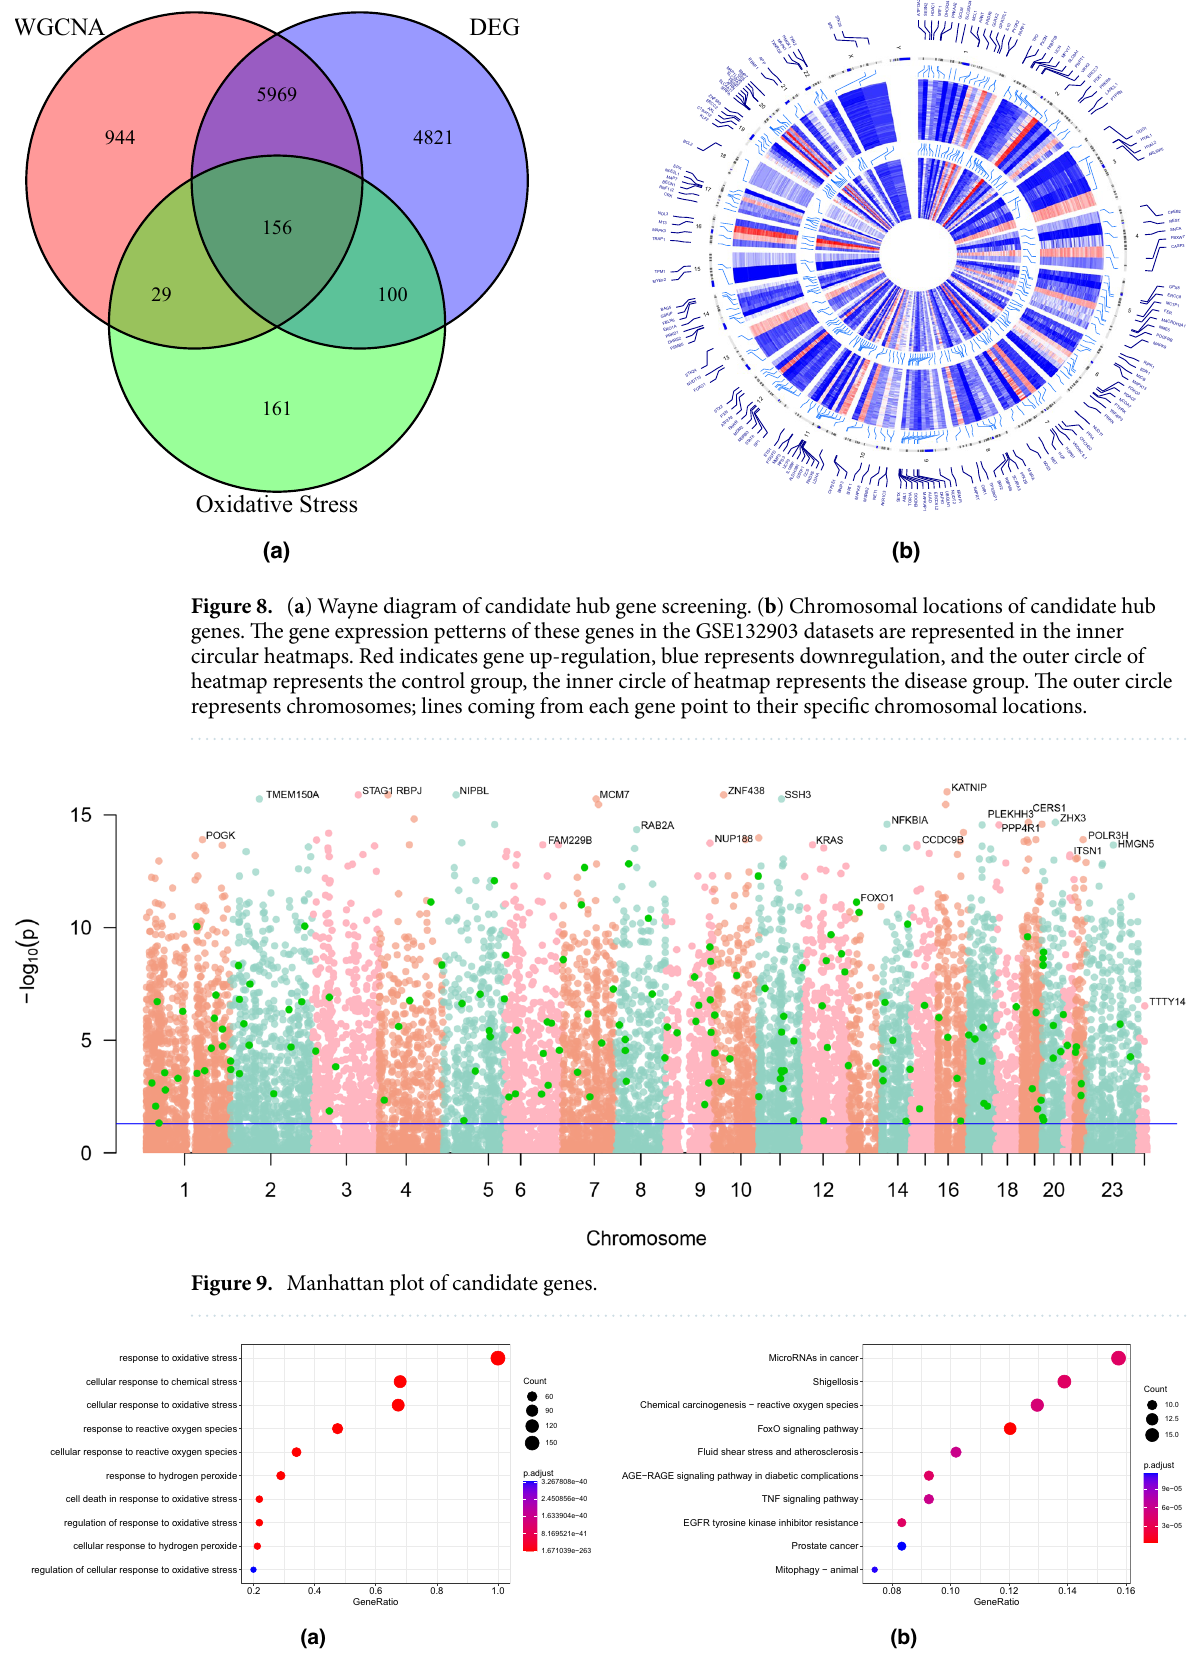
Figure 10. ( a ) GO enrichment analysis of candidate hub genes. ( b ) KEGG pathway enrichment analysis of candidate hub